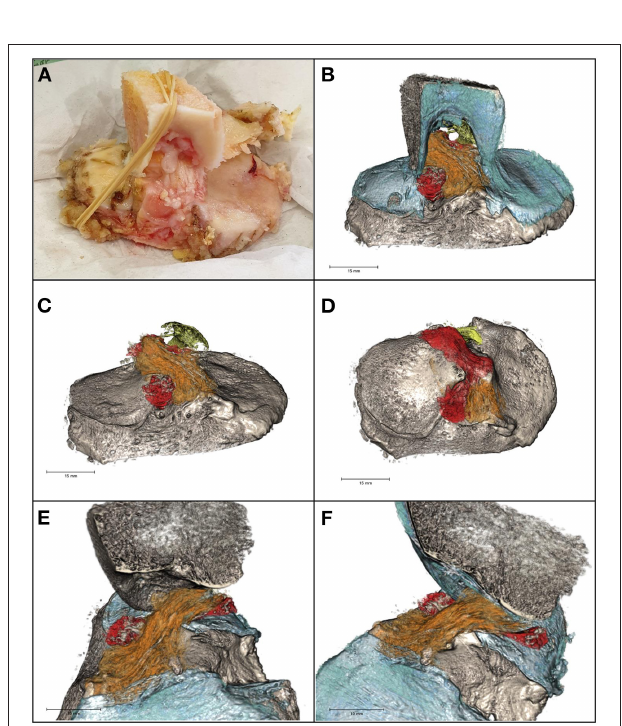
FIGURE 3 | (A) The specimen. (B) 3D model of intercondylar notch, tibial plateau, cartilage (blue), ACL (orange) and PCL (yellow) tibial insertions, and lateral meniscus posterior and anterior horn insertions (red). Calcifications (gray) within the cruciate ligaments and the meniscal insertions supplemental fibers were linear in shape. (C) Antero-posterior view of ACL, PCL, and lateral meniscus tibial insertions. (D) Axial view of ACL, PCL, and lateral meniscus tibial insertions. (E,F) Sagittal view of the tibial plateau, ACL, and lateral meniscus tibial